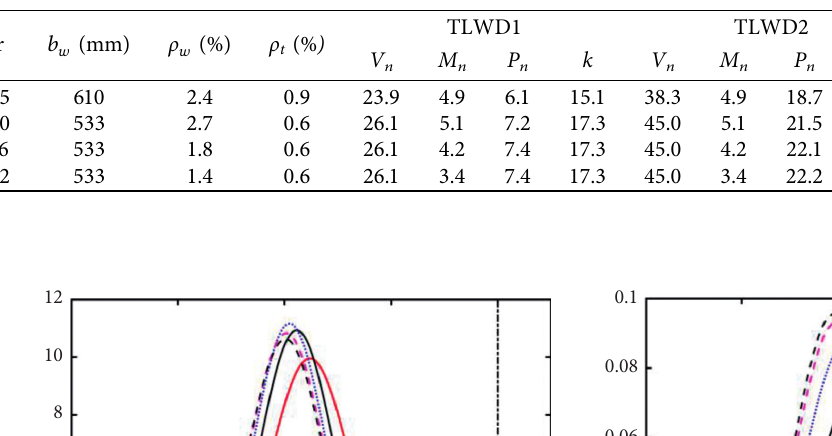
Table 11: Strength reduction (%) of the TLWDs compared to the original wall design.